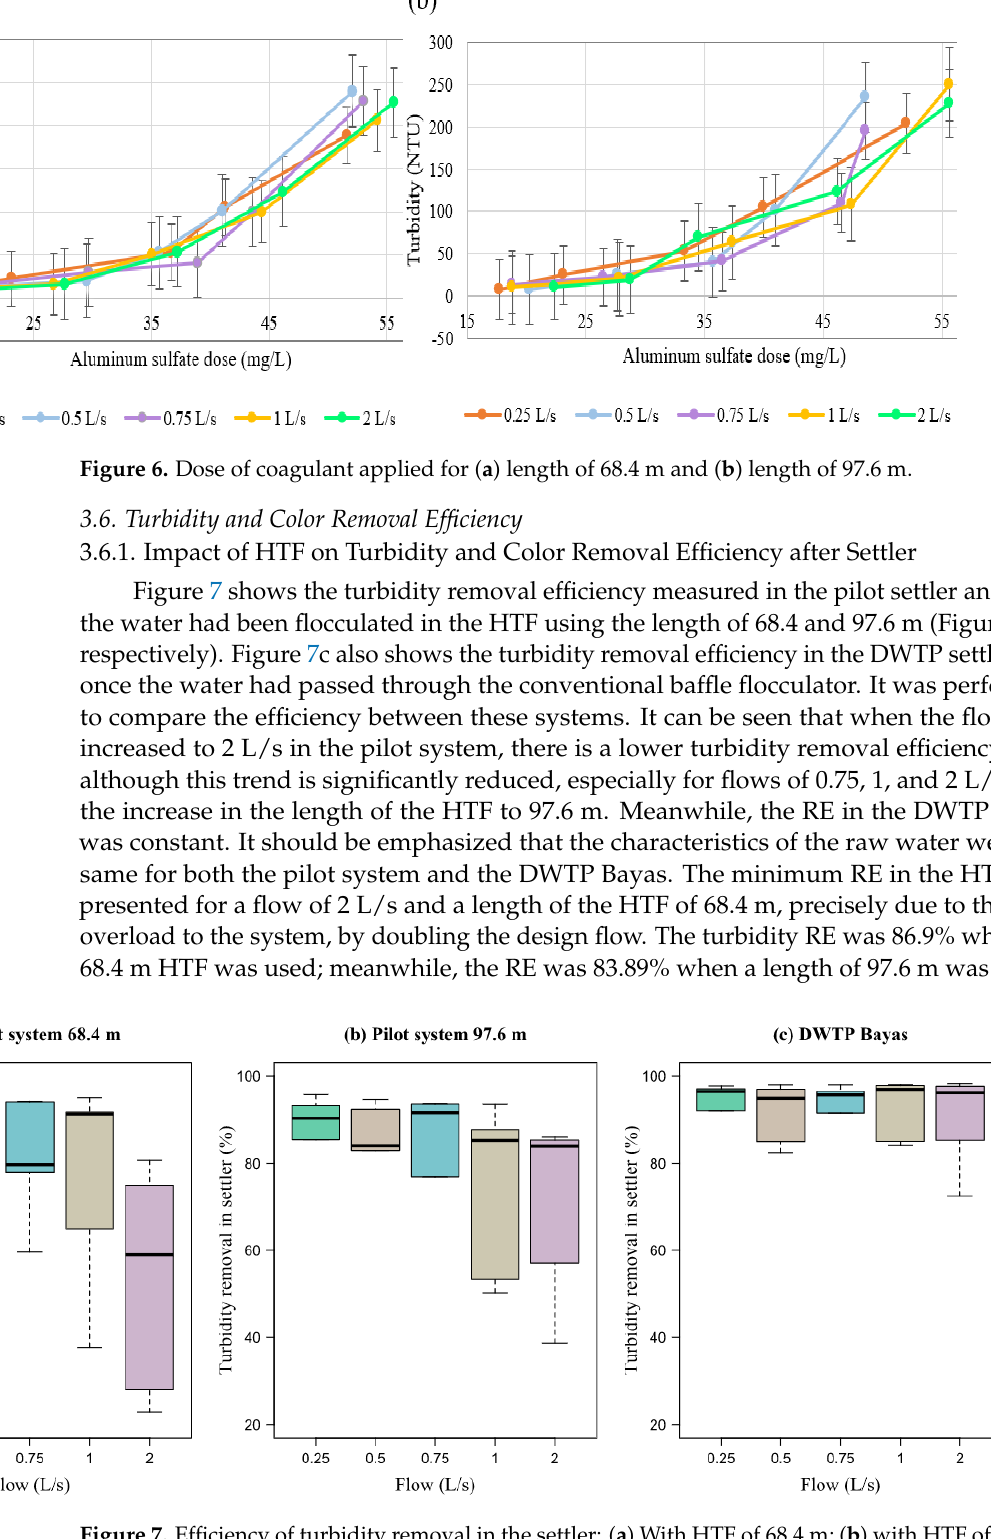
Figure 7. Efficiency of turbidity removal in the settler: ( a ) With HTF of 68.4 m; ( b ) with HTF of 97.6 m, and ( c ) in the filter of the DWTP “Bayas”. The bluish-green boxes correspond to a flow of 0.25 L/s, the brown boxes correspond to a flow of 0.5 L/s, the turquoise boxes correspond to a flow of 0.75 L/s, the beige boxes correspond to a flow rate of 1.0 L/s, purple boxes correspond to a flow rate of 2.0 L/s.